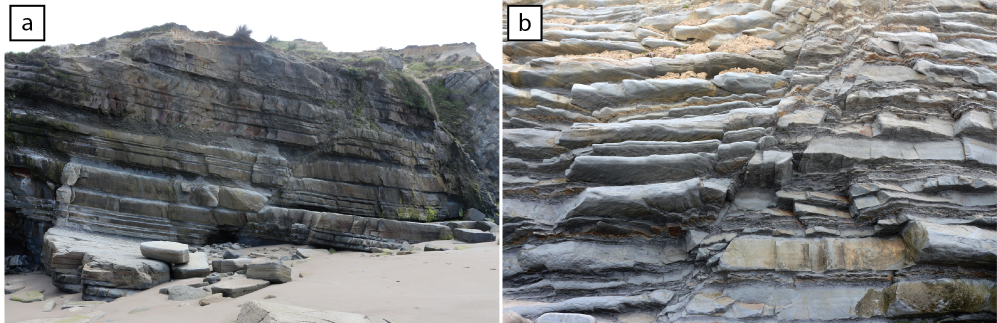
Figure 3. Field images of the different facies of the Whakataki Formation that dominantly host deformation bands and faults. (a) An outcrop- scale image of a sandstone-dominated sequence cut by a normal fault with ca. 1m displacement. (b) An outcrop-scale image of a sequence characterised by equal ratios of sand and mud cut by multiple normal faults. This sequence contains more faults than sandier